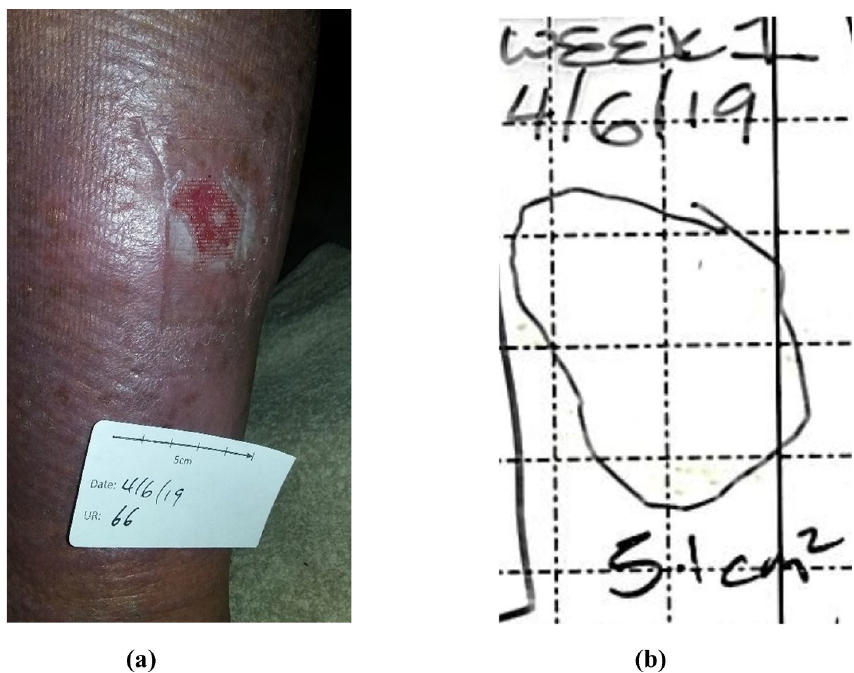
Figure 3. ( a ) An example of digital RGB image showing the ulcer on skin surface ( b ) Wound tracing to obtain the